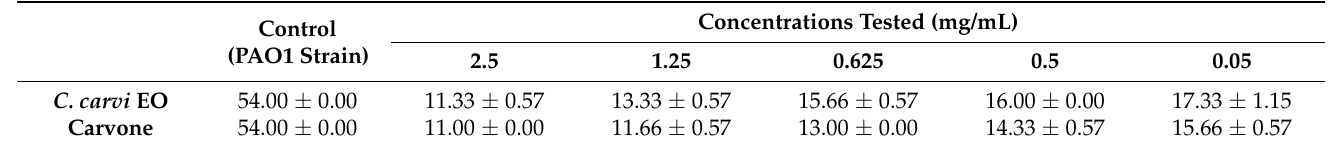
Table 4. Effect of caraway essential oil and its major compound (carvone) on the swarming activity of P. aeruginosa PAO1 strain expressed as mean diameter of growth on LB-0.5% agar (mm).